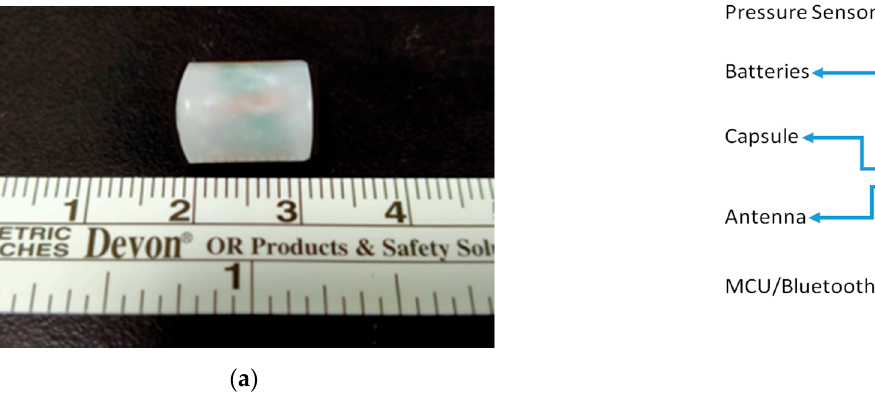
Figure 2. ( a ) The PressureDot ingestible wireless pressure sensing capsule, measuring 13 mm in length and 10 mm in diameter. ( b ) Illustration of the ingestible wireless pressure sensing capsule, composed of a biocompatible pressure sensor with a flexible antenna for wireless monitoring and recording of gastrointestinal intraluminal pressure and intraabdominal pressure.